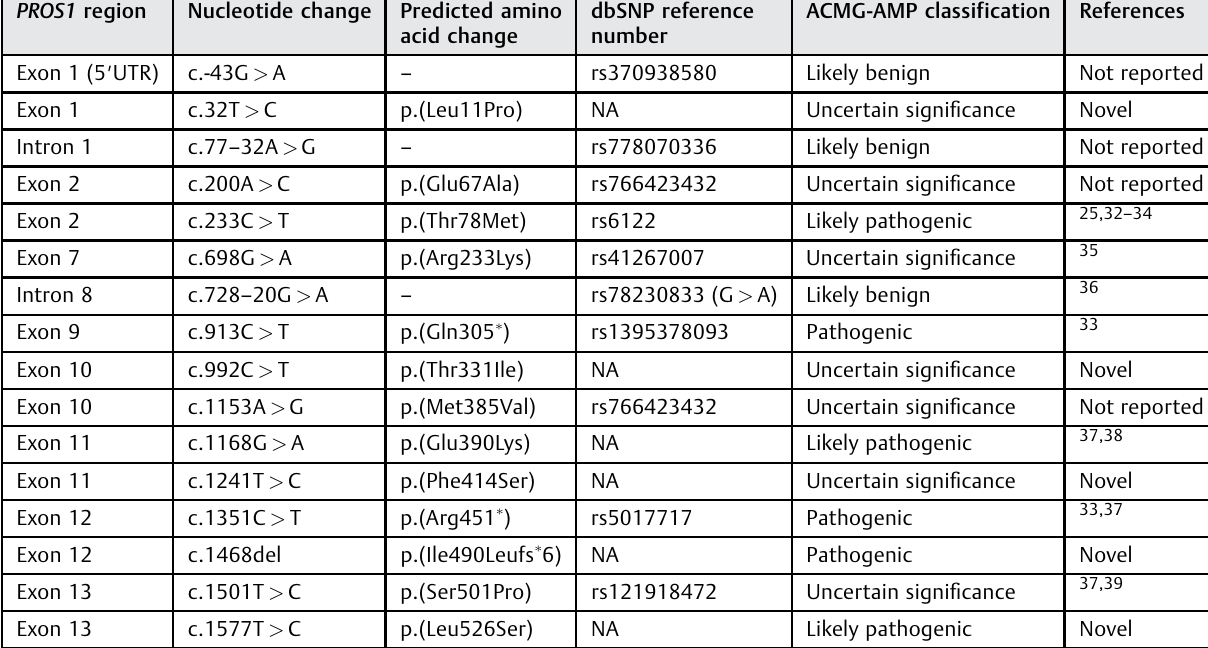
Table 2 Variants of the PROS1 gene identi fi ed in Danish participants PROS1